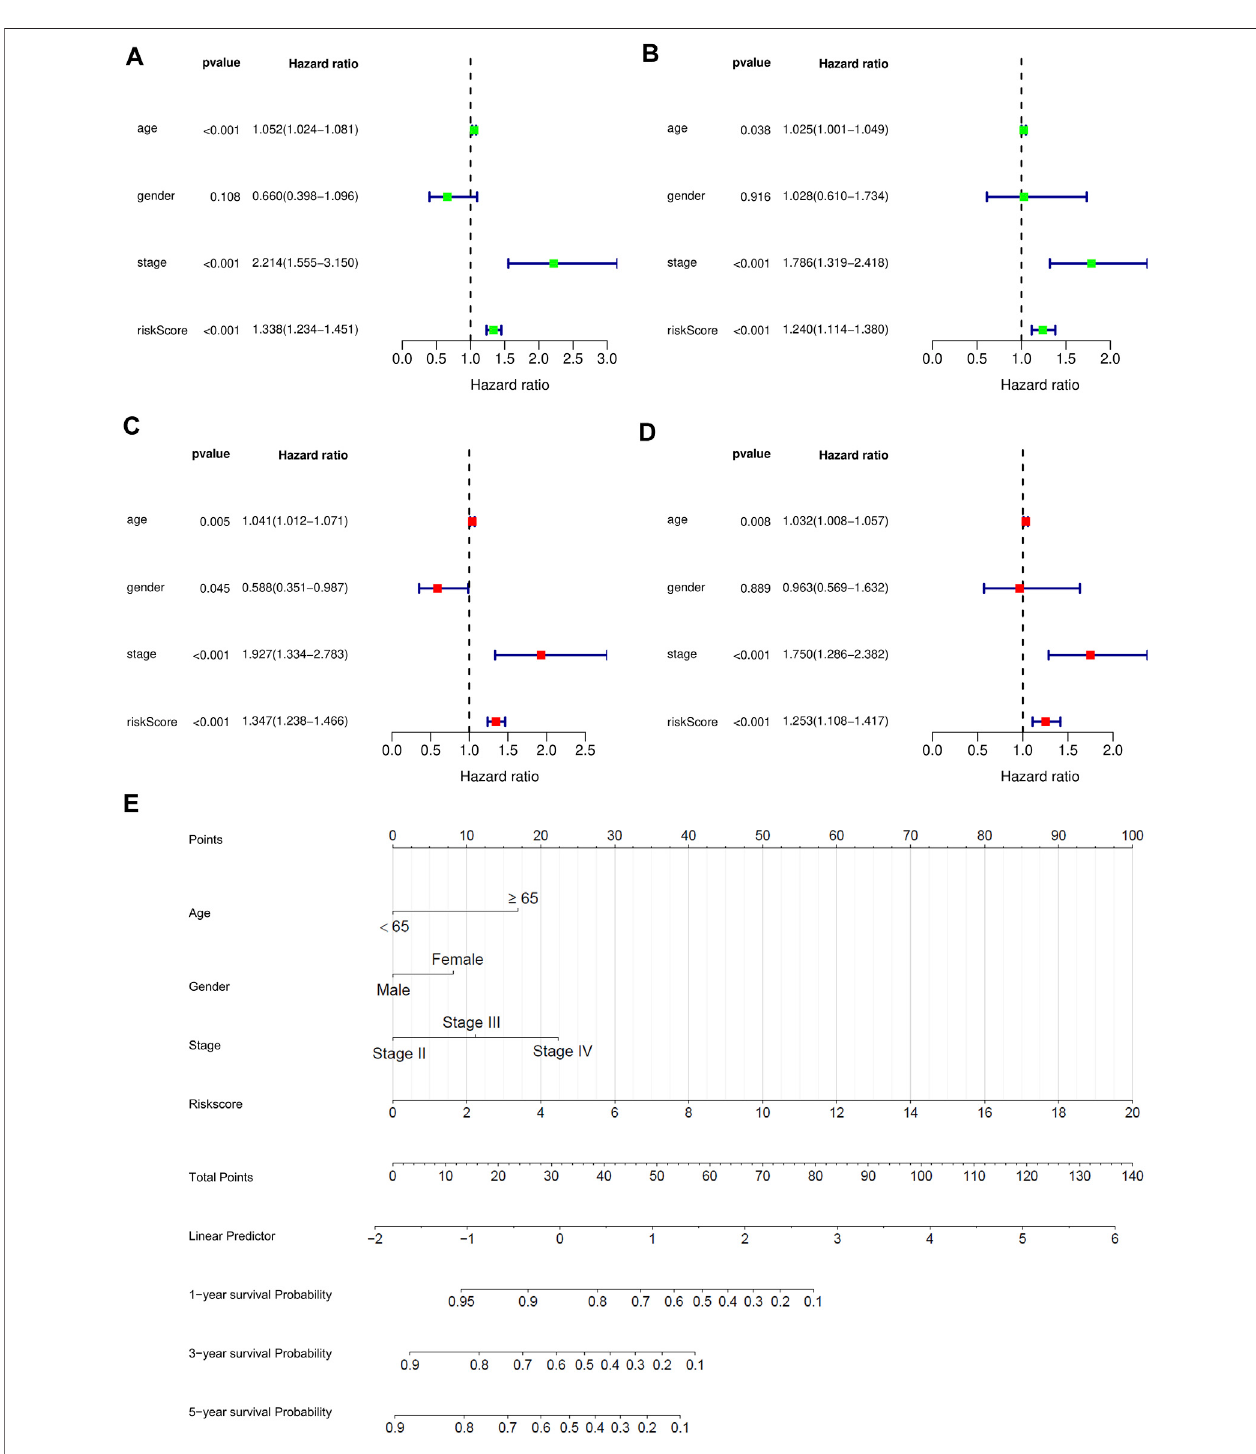
FIGURE7| Independentprognosticanalysisand1-,2-,and3-yearssurvivalpredictionwereperformedforbladdercancerpatientsinthetrainingandtestingsets. (A) Univariate prognostic analysis of training set. (B) Multivariate prognostic analysis of training set. (C) Univariate prognostic analysis of test set. (D) Multivariate prognostic analysis of test set. (E) The nomogram was used to predict 1-year, 2-years, and 3-years survival rates of bladder cancer patients in the training set.